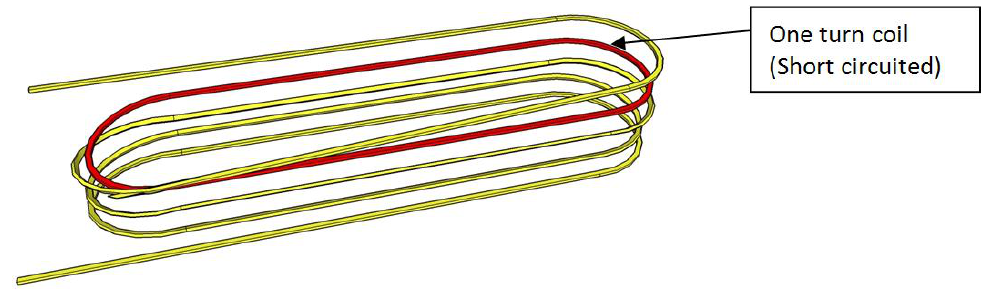
Figure 15. In this windings having 5 turns, one turn is short-circuited (In red) and it provided an undesirable standalone